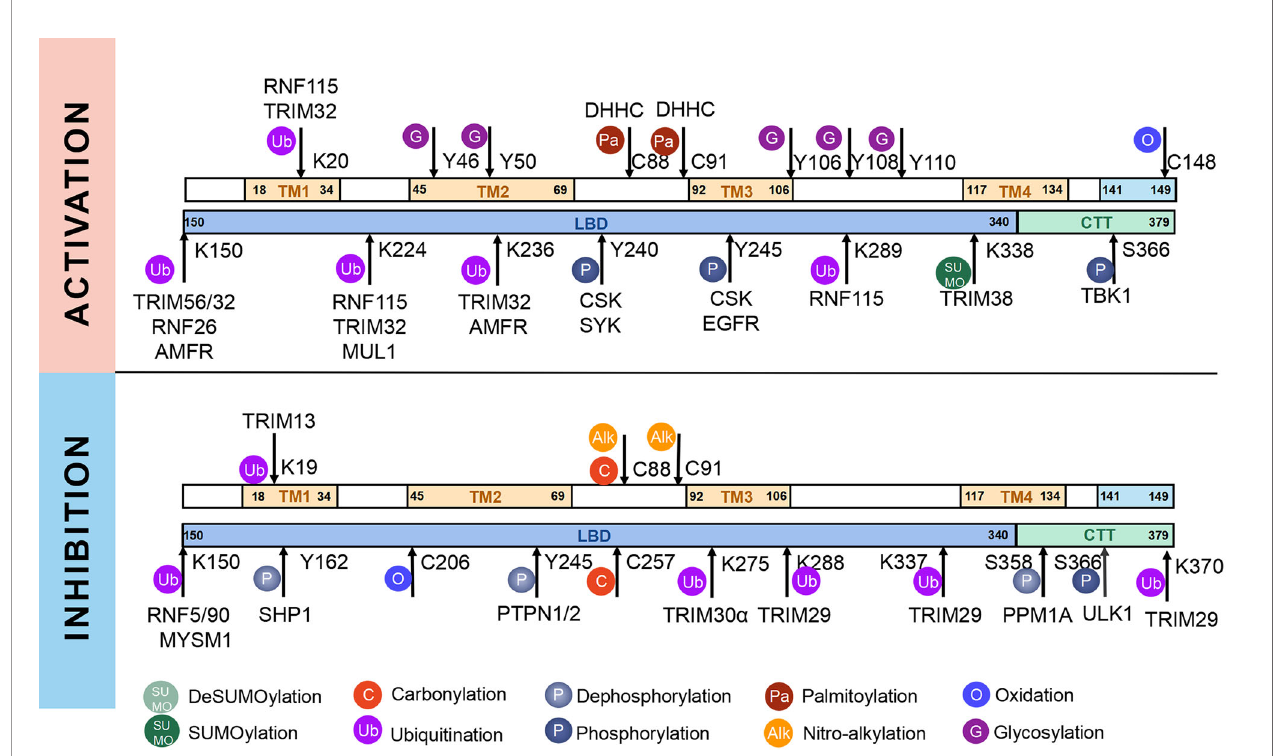
FIGURE 1 | Post-translational modi fi cations of STING. STING can be modi fi ed by phosphorylation and dephosphorylation, ubiquitination and deubiquitination, SUMOylation and deSUMOylation, palmitoylation, alkylation, glycosylation, carbonylation, oxidation, and disul fi de bond, which are indicated according to the keys in the bottom. The PTMs that promote activation of STING are shown above, whereas those that inhibit STING activation are shown below. Related enzymes are presented around the